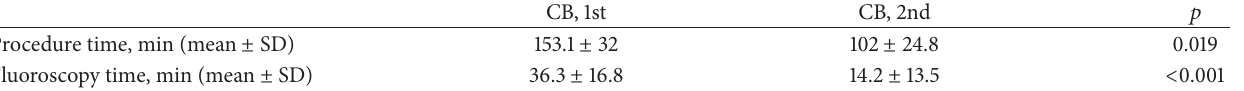
Table 2: Fluoroscopy time and procedure time comparison between the first- and second-generation CryoBalloon